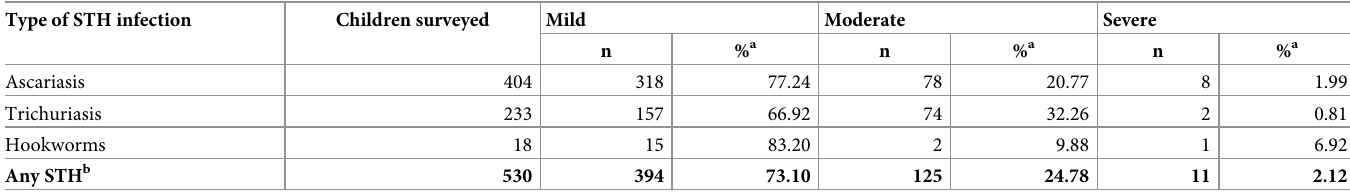
Table 4. Children surveyed and infected by the level of intensity of infection of soil-transmitted helminths, rural communities of Loreto Department, Peru 2017. Type of STH